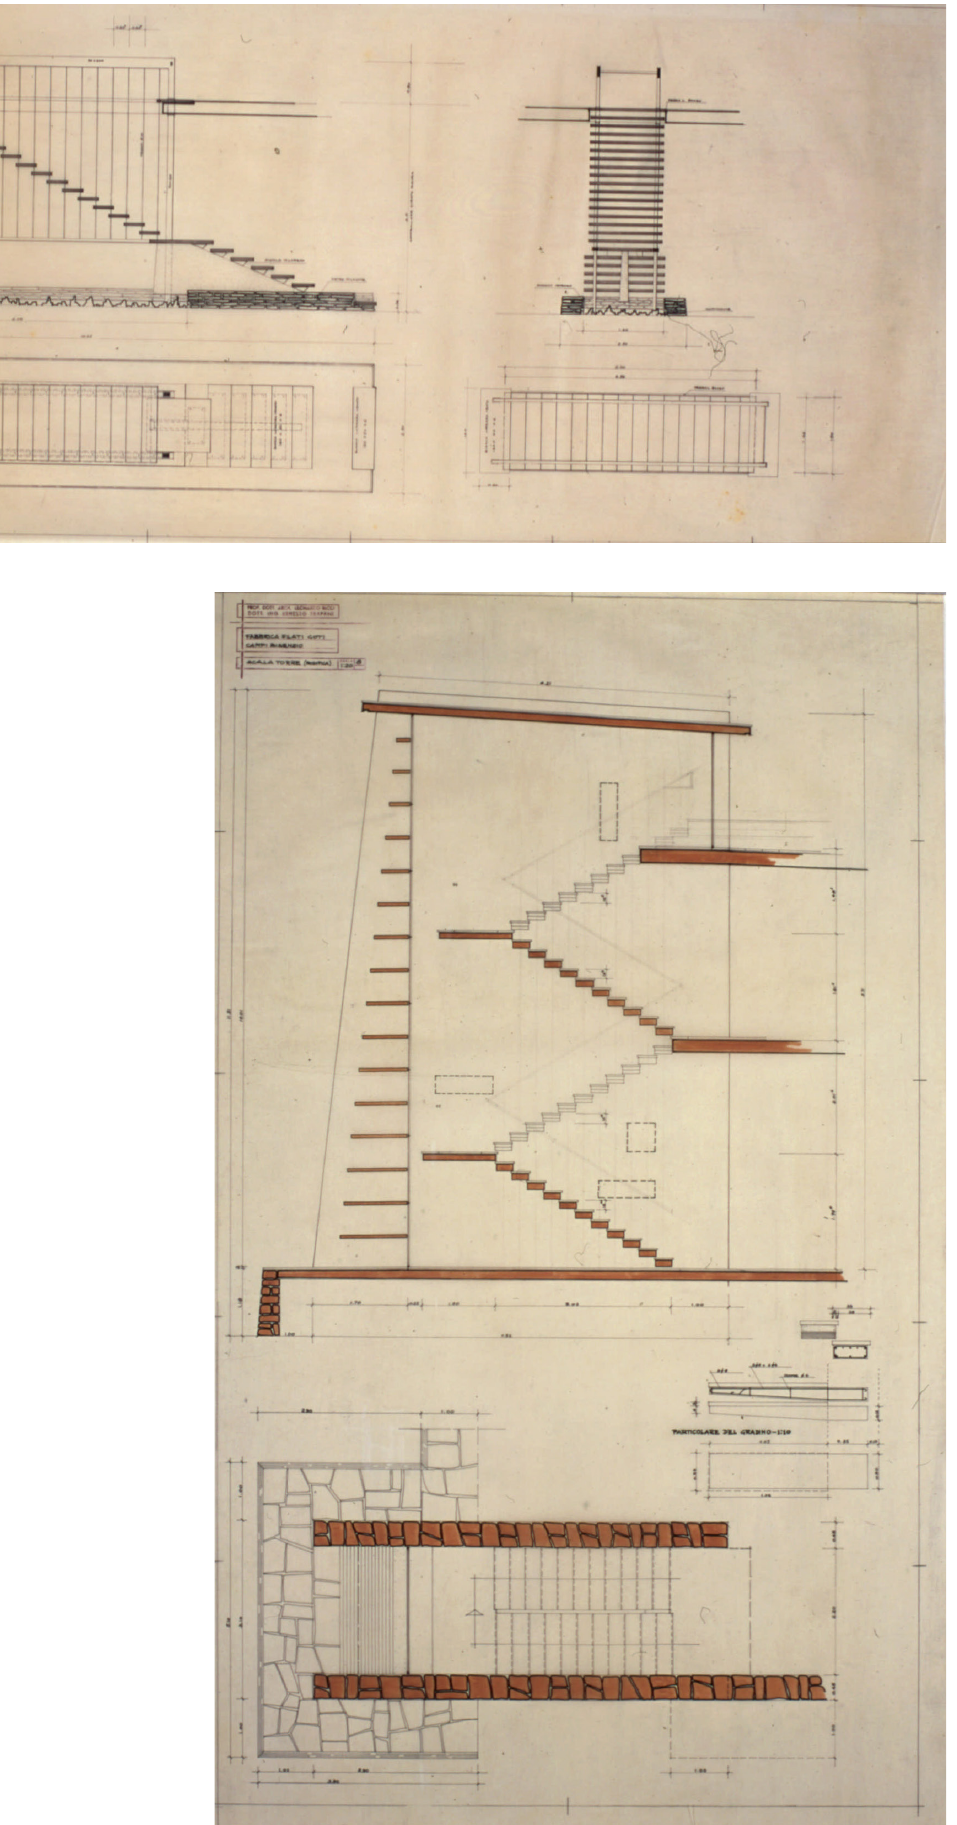
plan and section of the tower staircase, scale 1:20,